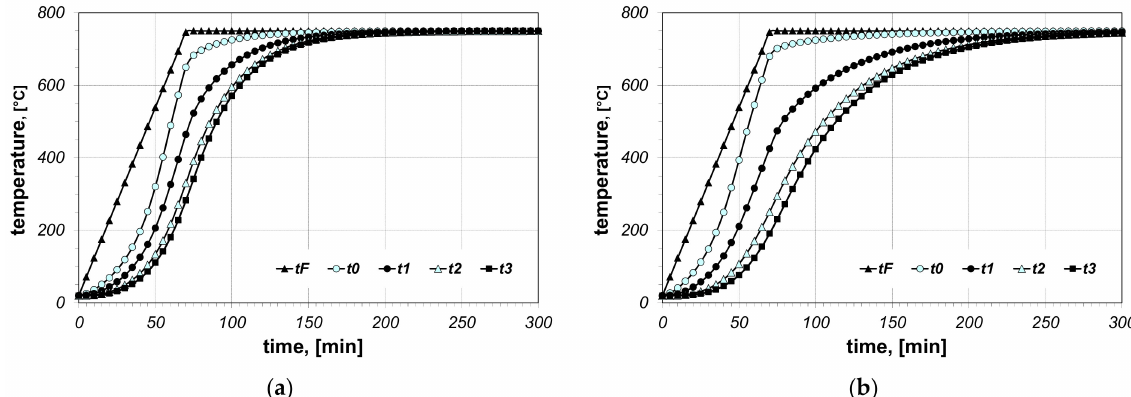
Figure 9. Calculated values of temperatures for heating of a 10 × 40 bar bundle with horizontal arrangement: ( a ) results obtained for R ct-min , ( b ) results obtained for R ct-max .